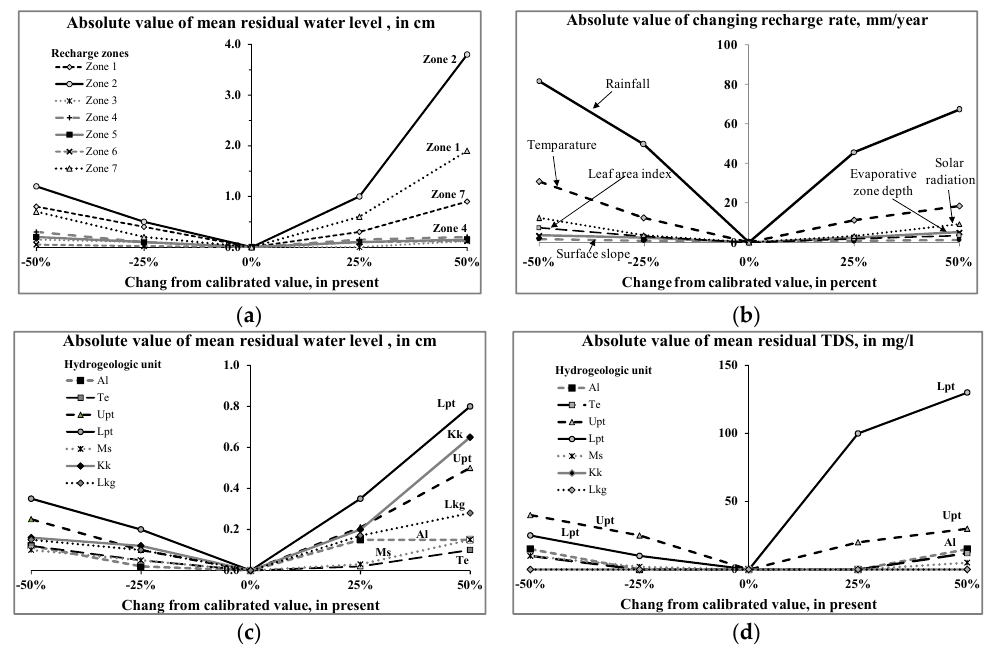
Figure 14. A sensitivity analysis of the calibrated models. ( a ) a sensitivity analysis of recharge rate of each zone of SEAWAT model; ( b ) a sensitivity analysis of recharge input parameter in the HELP model; ( c ) a sensitivity analysis of groundwater level of hydraulic conductivity of hydrogeologic unit; ( d ) a sensitivity analysis of groundwater salinity of longitudinal dispersivity of hydrogeologic